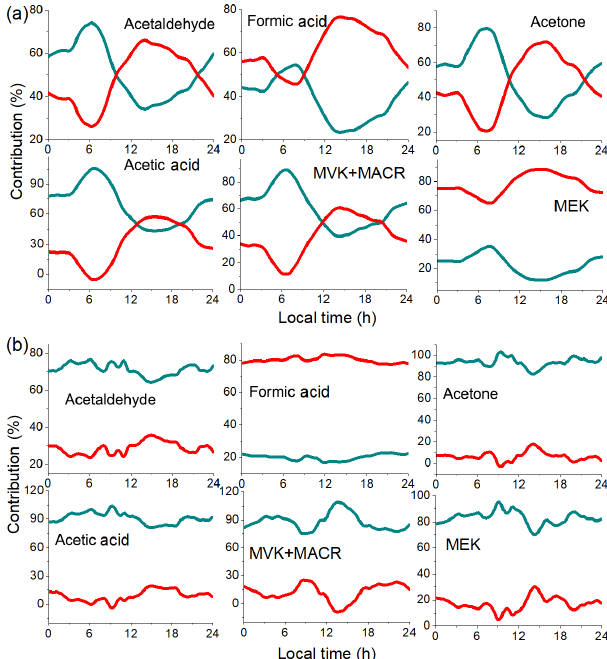
Figure 8. Contributions of anthropogenic (cyan) and bio- genic/secondary (red) sources to OVOC concentrations at the urban site (a) and the suburban site (b)